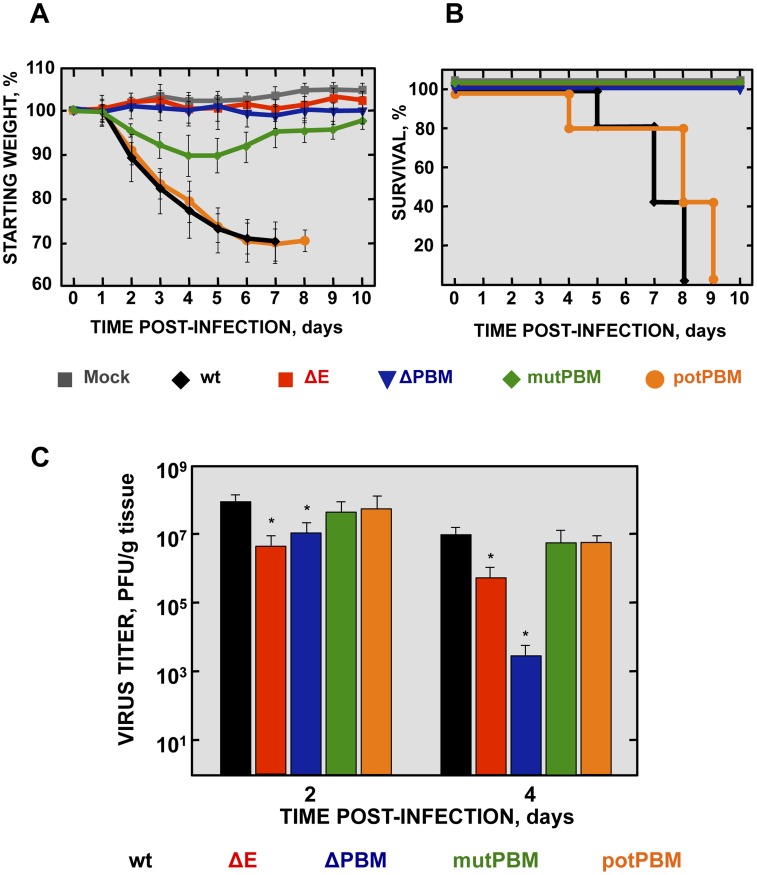
Virulence and viral growth of SARS-CoV-E-PBM-infected mice.16-week-old BALB/c mice were intranasally inoculated with 100,000 pfu of wt, ΔE, ΔPBM, mutPBM and potPBM viruses. Weight loss (A) and survival (B) were monitored for 10 days. Data represent two independent experiments with 5 mice per group. Differences in weight loss between attenuated and virulent viruses were statistically significant (P<0.01). (C) Viral titer in lungs was determined at 2 and 4 days post infection (n = 3, each day). Error bars represent standard deviations. Statistically significant data are indicated with one (P<0.05) asterisk.